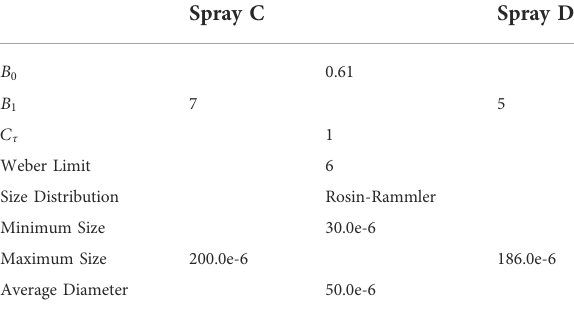
TABLE 1 Breakup model speci fi cations for Spray C and Spray